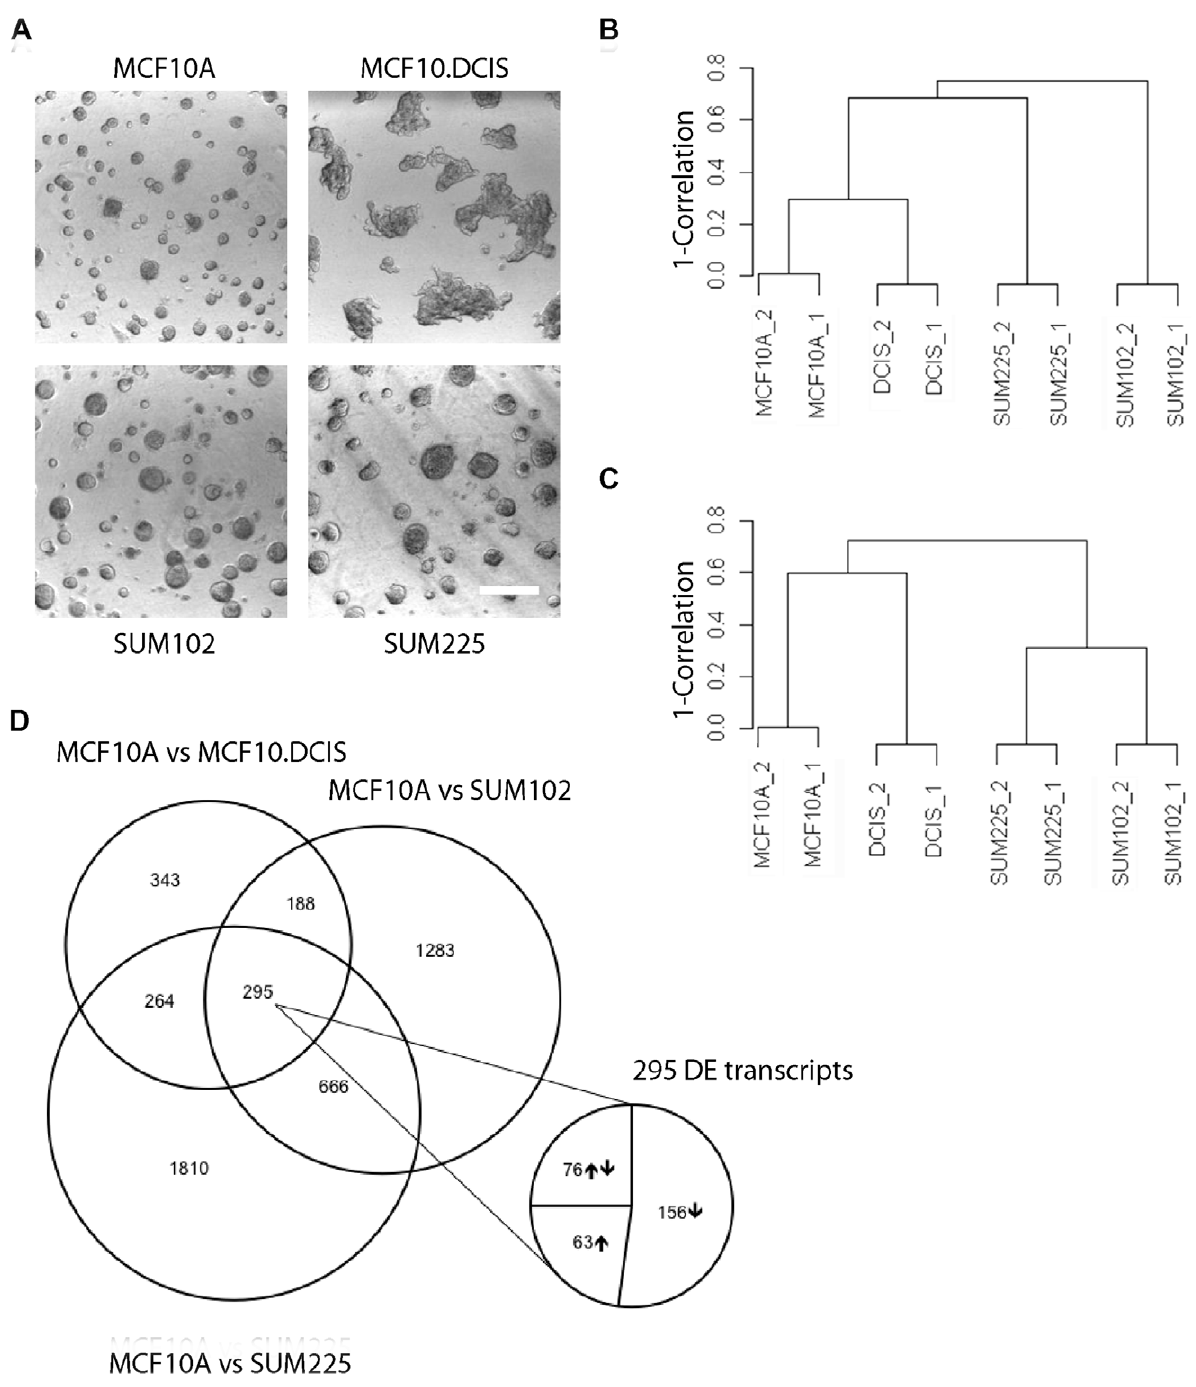
Figure 1. RNA-Seq analysis of MCF10A and DCIS models ( A ) Differential interference contrast (DIC) images of 12-day 3D rBM overlay cultures of MCF10A, MCF10.DCIS, SUM102, and SUM225 cells. Scale bar, 200 m m. ( B ) Unsupervised hierarchical clustering of the transcript profile from the eight RNA-Seq samples. ( C ) Cluster dendrogram of RNA-Seq samples based on differentially expressed genes. ( D ) Venn diagram of differential expression results (with a p-value , 0.001 and cut-off fold change of 4) showing the overlap between the genes expressed by different models of DCIS in comparison to MCF10A. There are a total of 295 genes that are consistently differentially expressed between the MCF10A and the three DCIS models: MCF10.DCIS, SUM102 and SUM225. The expansion shows that 156 transcripts were decreased, 63 transcripts were increased, and 76 transcripts were differentially expressed in all three models but the direction of change was variable. doi:10.1371/journal.pone.0050249.g001 their pattern of up and down regulation was not consistent. The largest extent in all three models of DCIS are depicted with genes identified by RNA-Seq as differentially expressed to the their fold change values in Table 1.